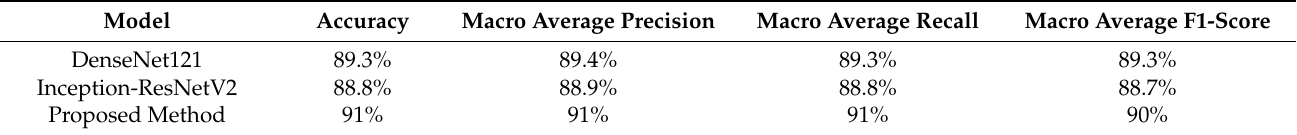
Table 9. The comparison of the performance results of the single model with the proposed model.